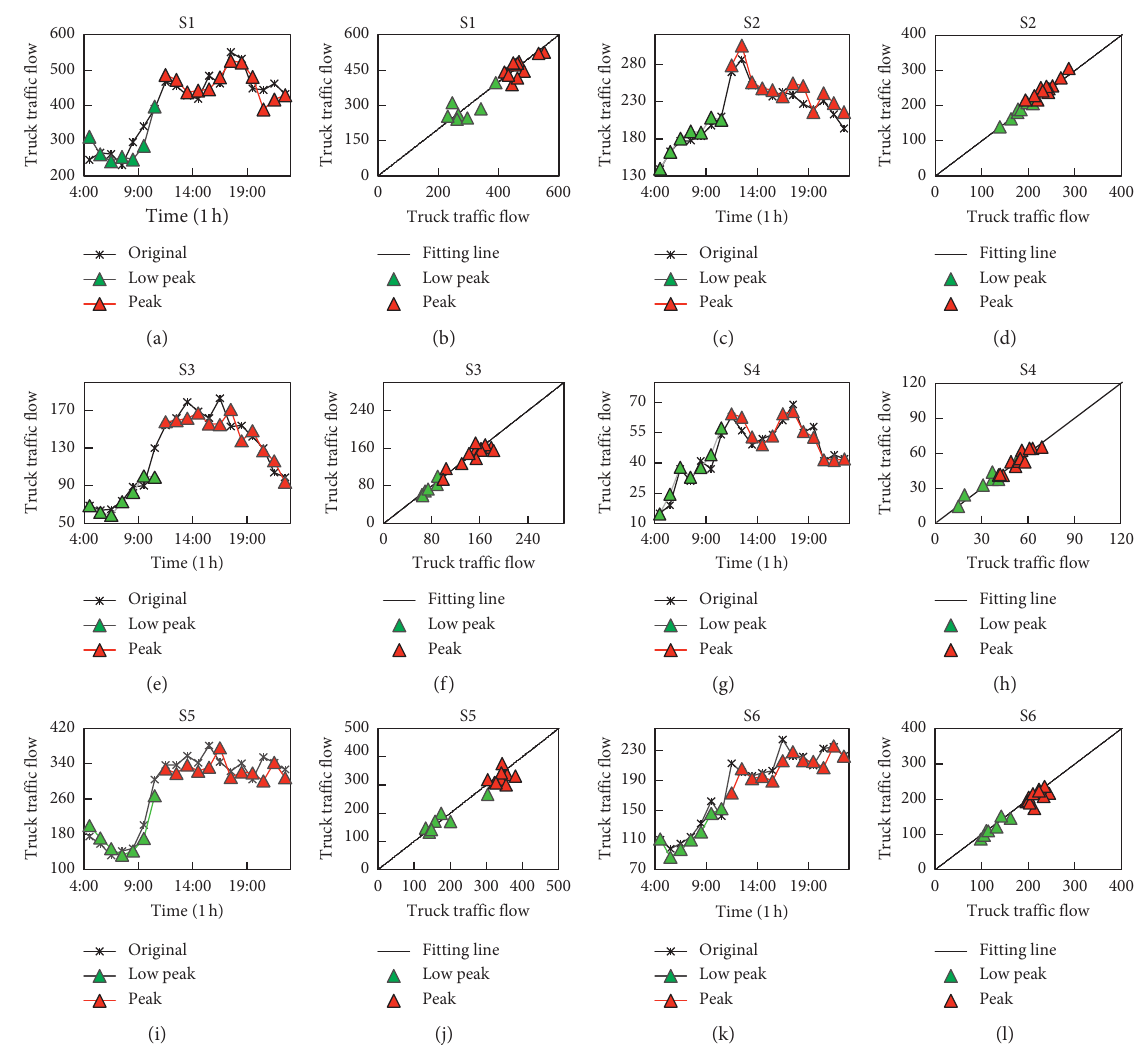
Figure 10: Comparison of the predicted truck flow of peak and low